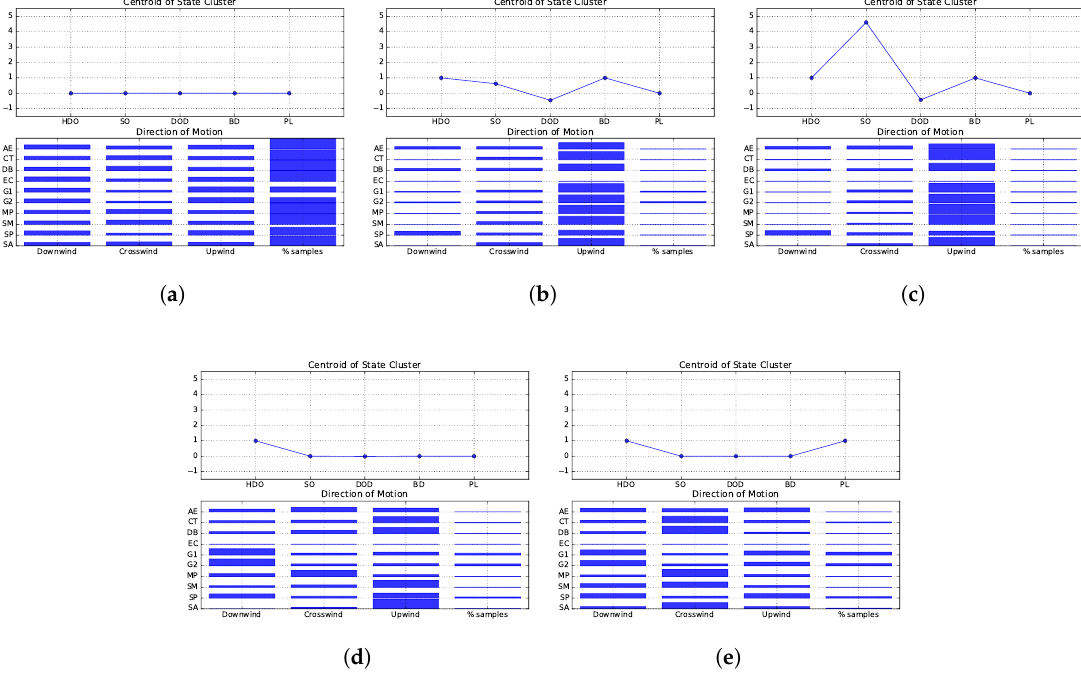
Figure 9. 5 state-action mappings for environment 2. The top of each sub-figure presents the centroid of the respective state cluster. The bottom of each sub-figure presents the stacked histograms of relative frequency of the actions taken by each strategy in the respective state. A fourth bar is added to the histogram of each strategy, representing the percentage of simulation steps spent perceiving the corresponding state. ( a ) State 1: the robot has yet to sense any odour concentration; ( b ) State 2: the robot is detecting low concentrations of odour; ( c ) State 3: the robot is detecting high concentrations of odour; ( d ) State 4: the robot has recently stopped detecting odour; ( e ) State 5: the robot has lost the plume for an extended time